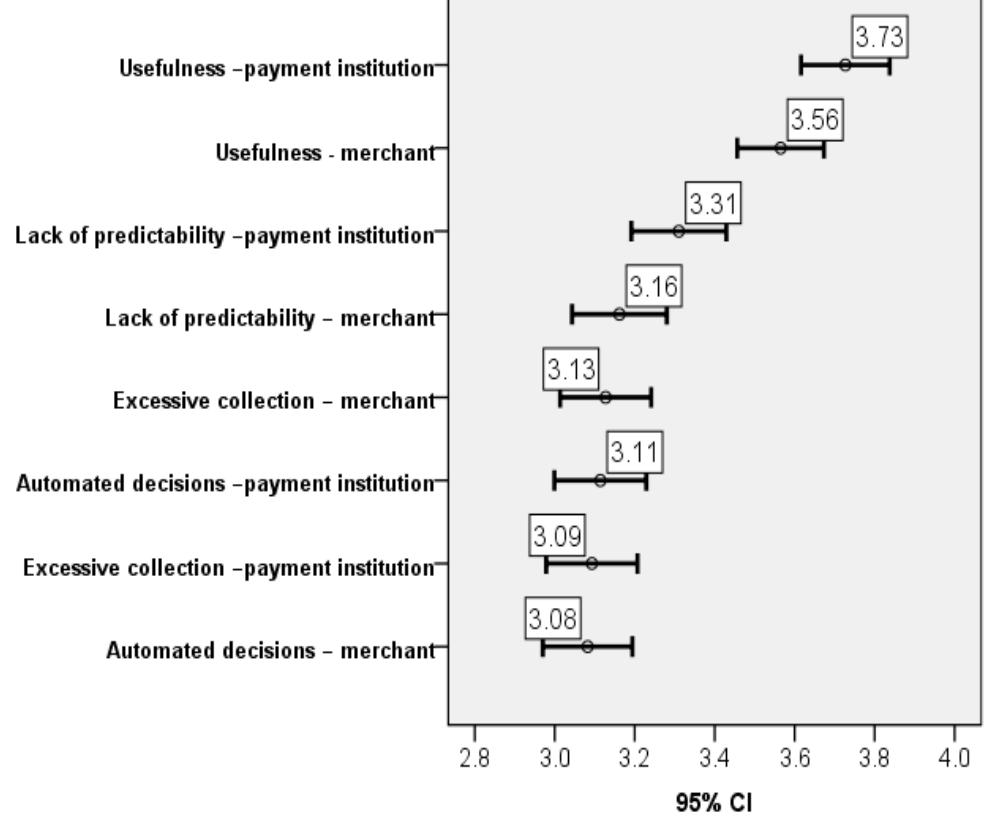
Figure 2. Data aggregation and use of AI. Source: Authors’ processing in SPSS 24.